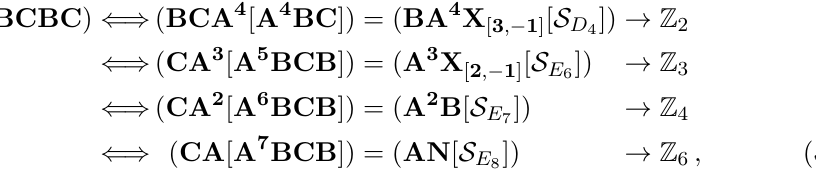
gauge theory is all affine E symmetry, which can n 8